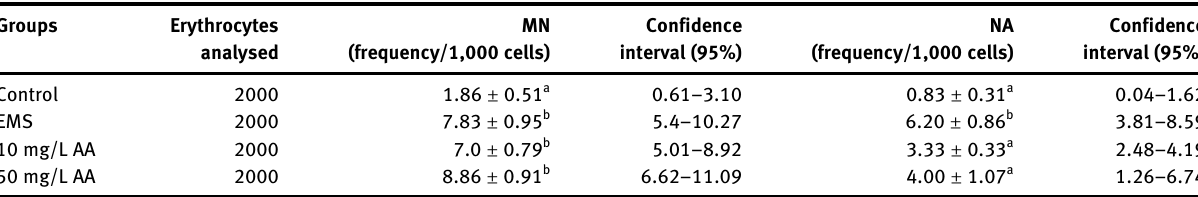
Table  : Frequency of micronucleated cells ( ‰ , MN) and nuclear abnormalities ( ‰ , NA) in carp exposed to sublethal acrylamide for  h (mean ± S.E.M.; n= 